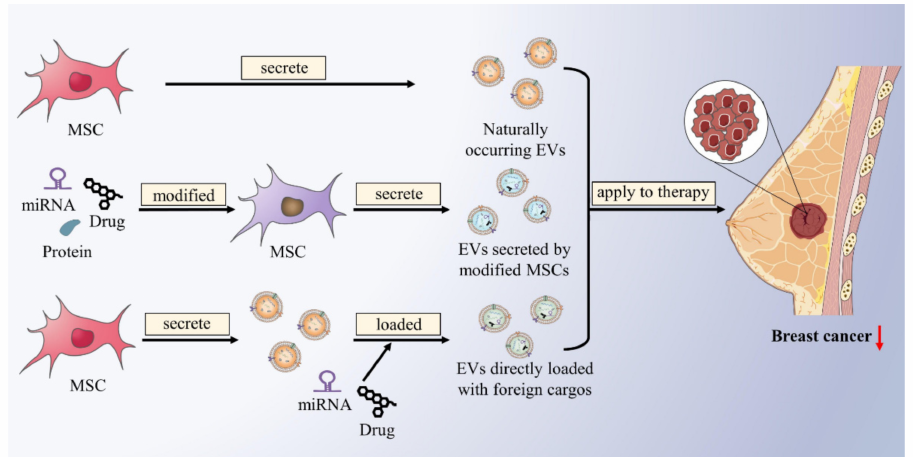
Figure 3. Naturally occurring and engineered MSC-EVs loaded with endogenous or exogenous cargos for therapeutic purposes. Naturally occurring MSC-EVs contain functional components that inhibit BC development. MSCs can be modified to produce EVs loaded with miRNAs, proteins, or anticancer drugs. Exogenous cargos, such as miRNA and chemotherapeutic drugs, can be loaded into MSC-EVs through engineering techniques. Naturally occurring and engineered MSC-EVs can act on BC to produce therapeutic